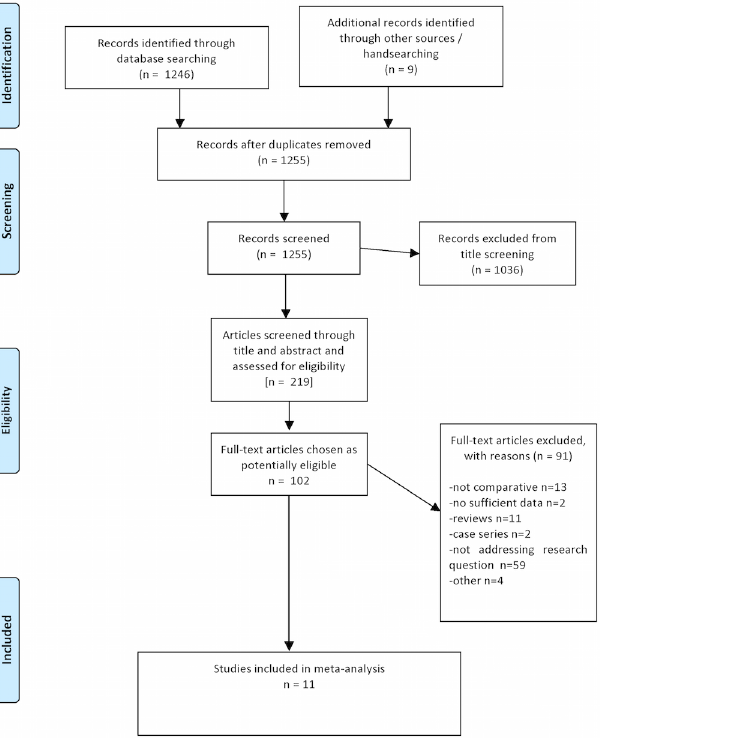
Fig 1. PRISMA Flow Diagram of the studies.